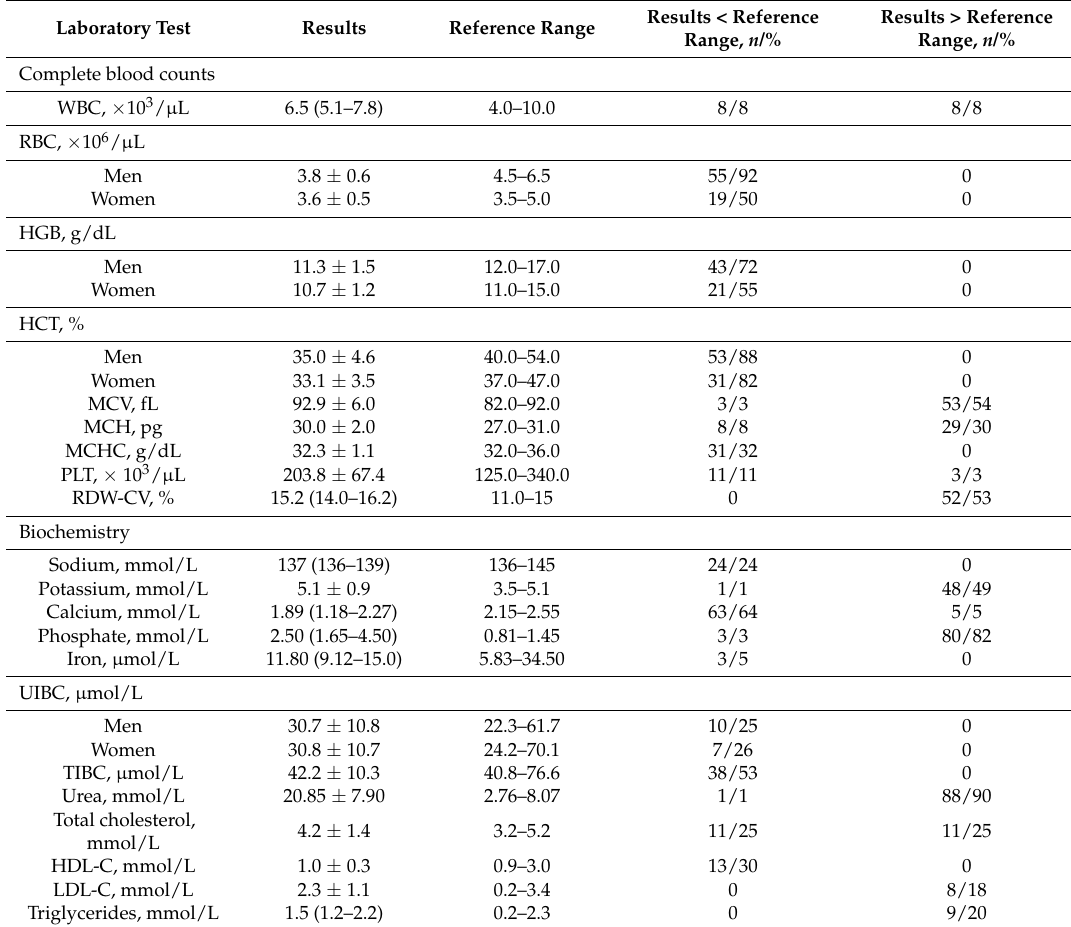
Table 5. The results of laboratory tests in the study